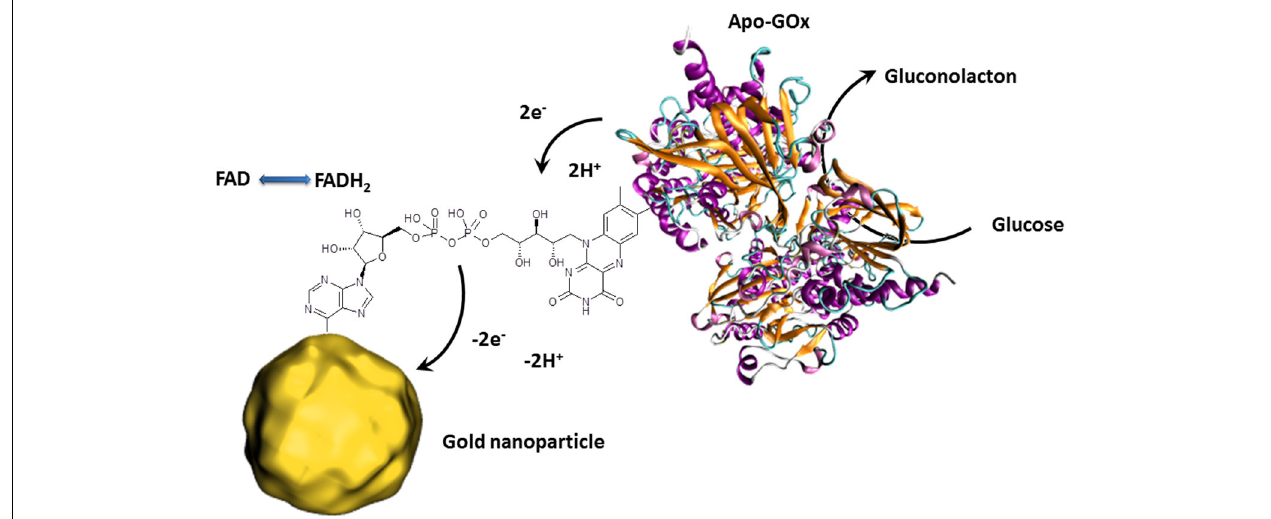
FIGURE 3 | Schematic presentation of the reconstitution of apo-GOx with FAD modified gold nanoparticles enabling the transfer of electron released by the electrocatalytic oxidation of glucose. The collected electrons are then directly transferred to the external circuit giving an electrochemical signal.